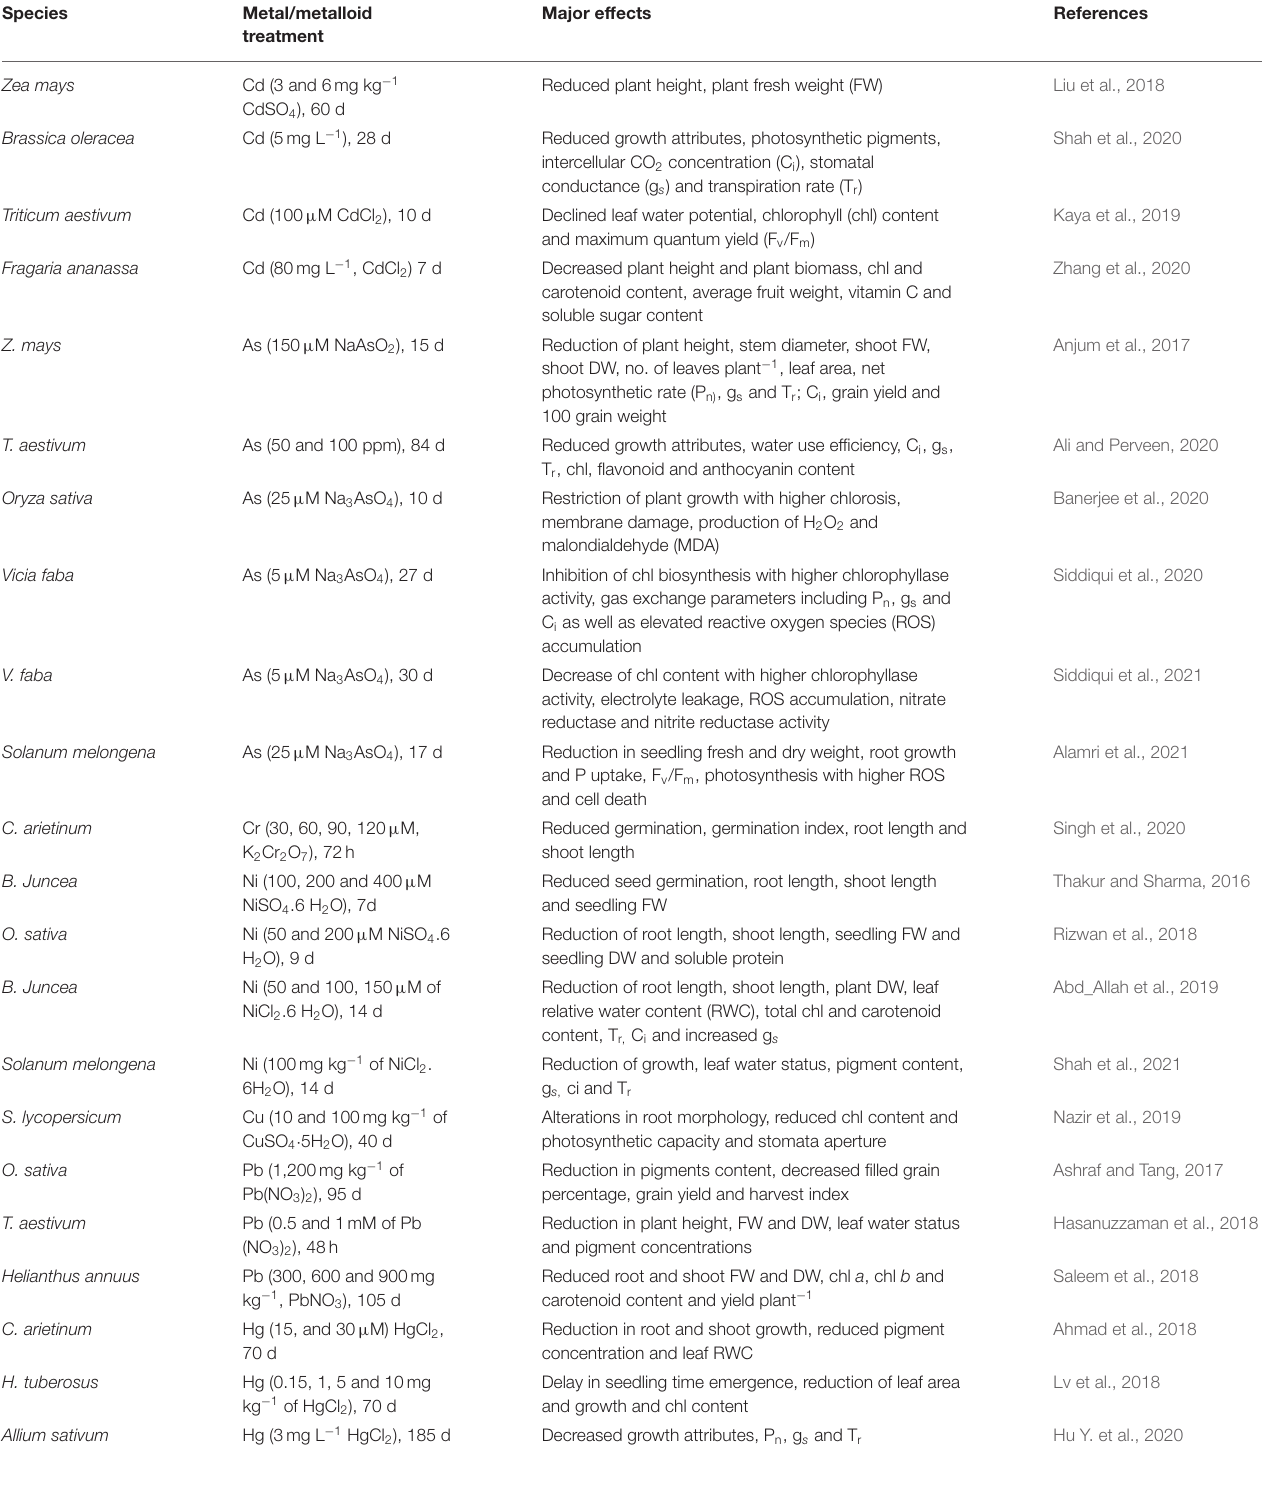
TABLE 1 | Influence of metal/metalloid toxicity on different